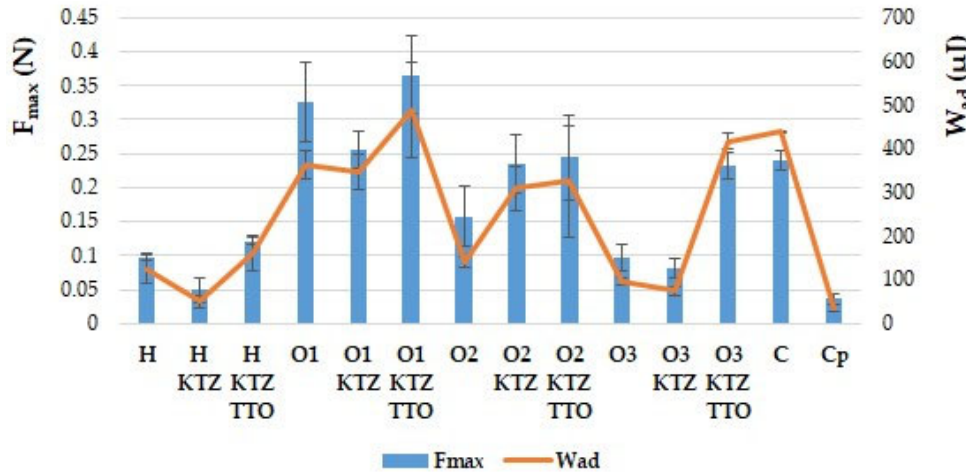
Figure 3. Ex vivo bioadhesive properties of prepared PLU ® F ‐ 127 hydrogels and PLO organogels containing KTZ (H KTZ, O1 KTZ, O2 KTZ, O3 KTZ), KTZ and TTO (H KTZ TTO, O1 KTZ TTO, O2 KTZ TTO, O3 KTZ TTO), placebo gels (H, O1–O3), and controls: commercially available product (C) and cellulose paper (C p ) determined as the maximum detachment force (F max ) and the work of adhesion (W ad ). Values are expressed as means ± SD of six replicates; p ˂ 0.05.